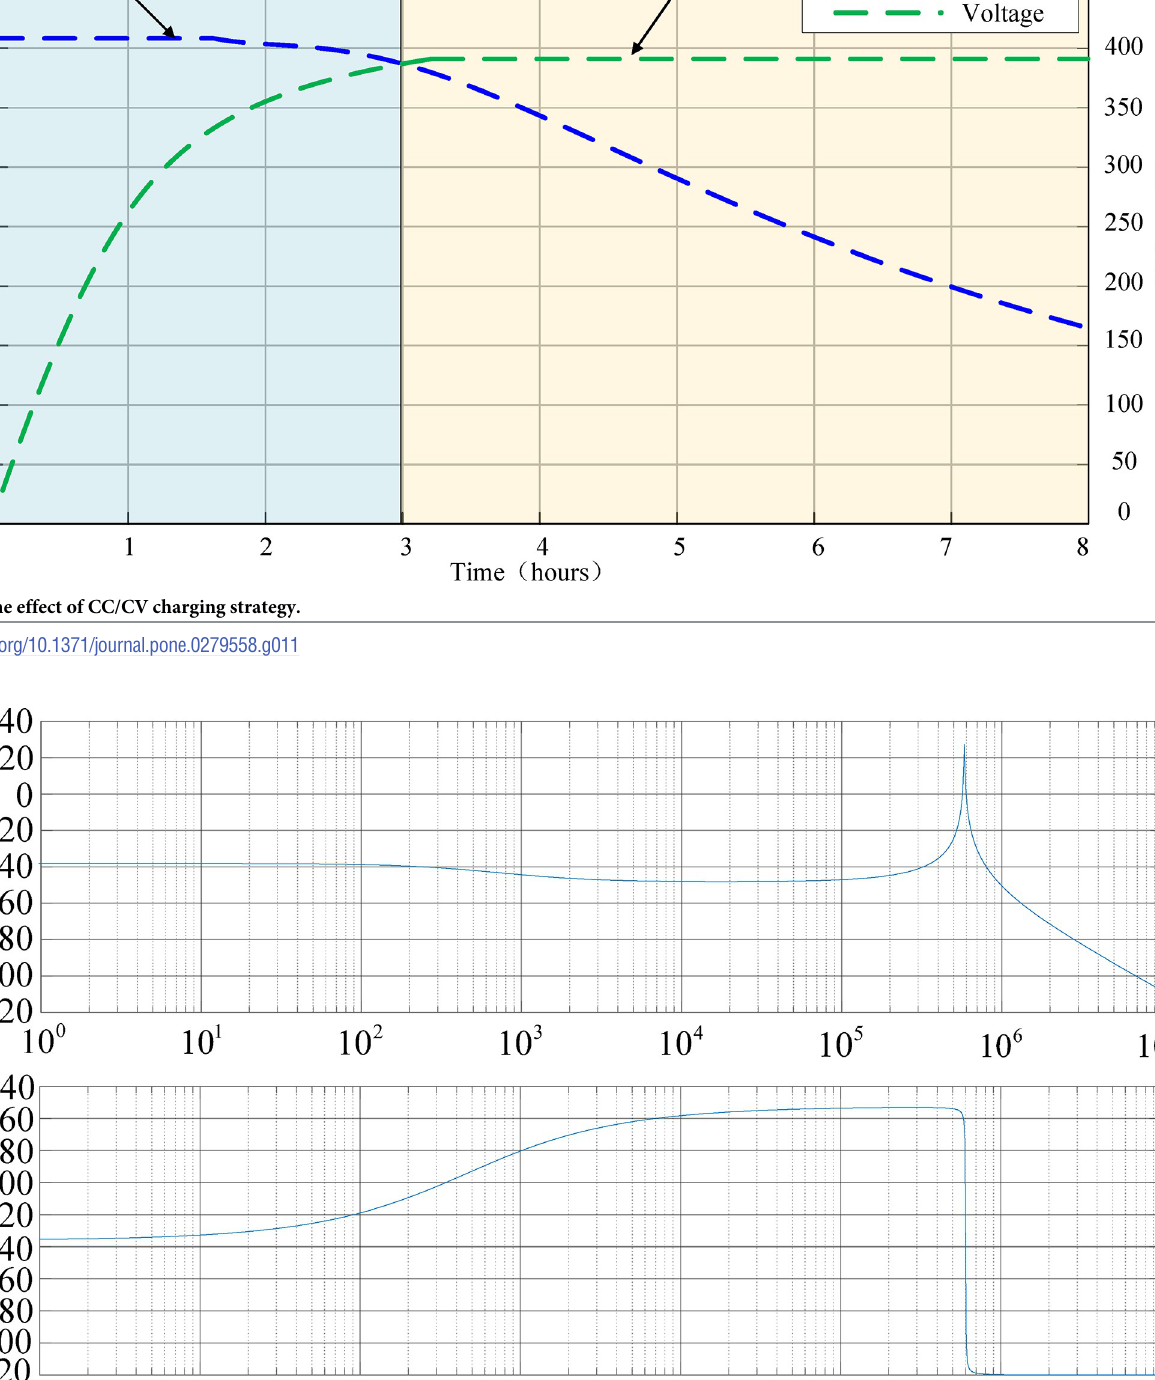
PLOS ONE | https://doi.org/10.1371/journal.pone.0279558 February 24,